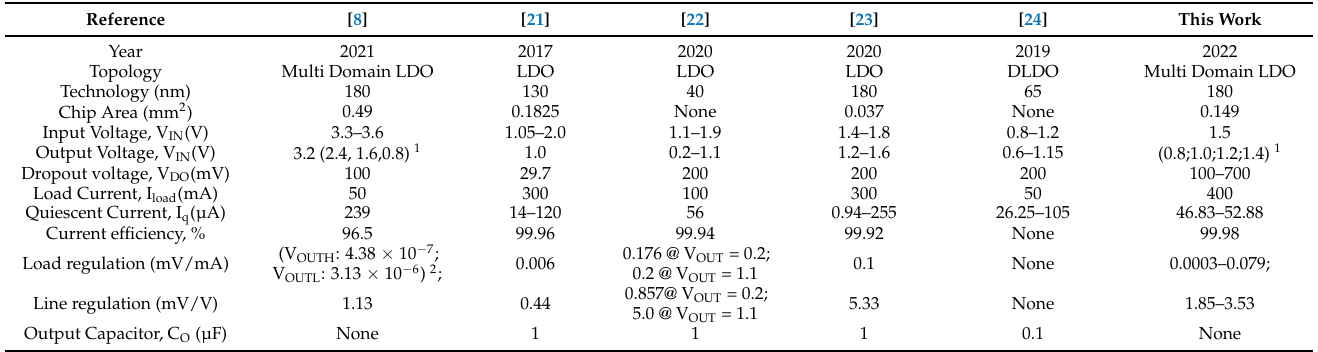
Table 3. Summarized performance of proposed MVD-LDO compared with other state-of-the-art